Question: What form of chart is displayed?
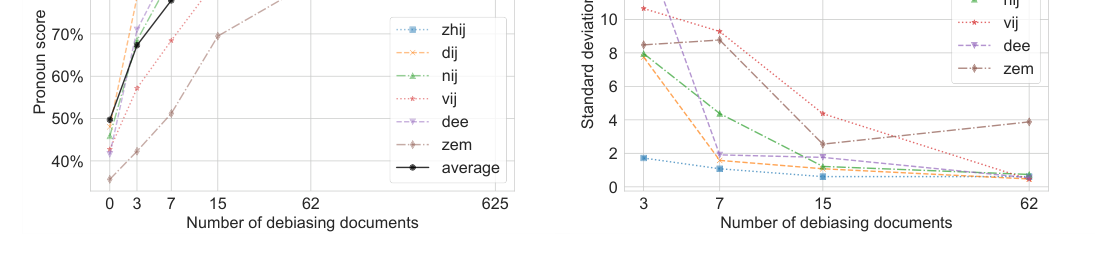
Answer: line